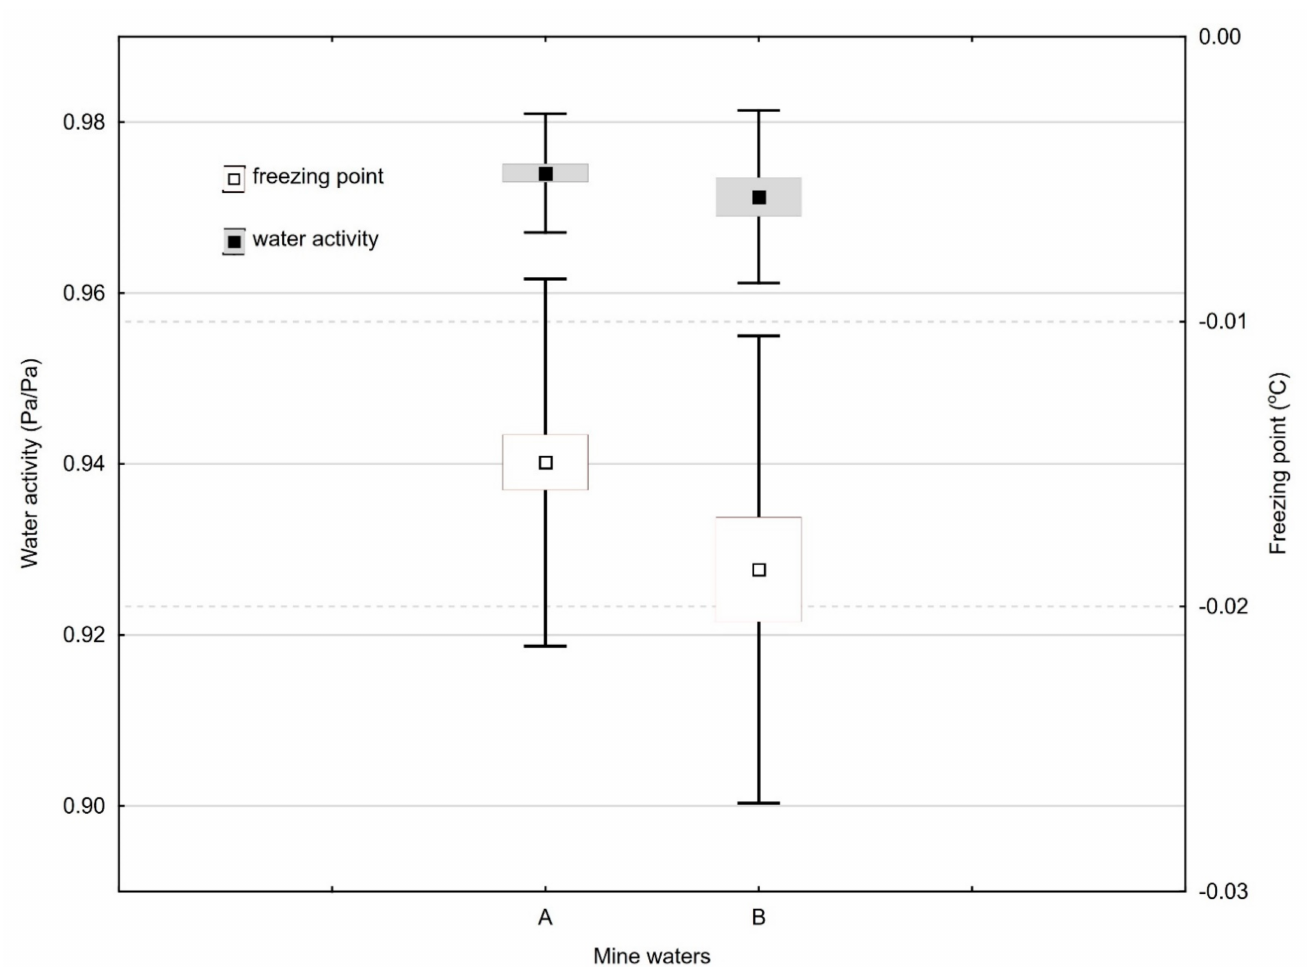
Figure 1. Water activity and freezing point of mine waters (mean ± SD; P 5 –P 95 ). A, mine waters from deep-seated drainage; B, mine waters from surface drainage; SD, standard